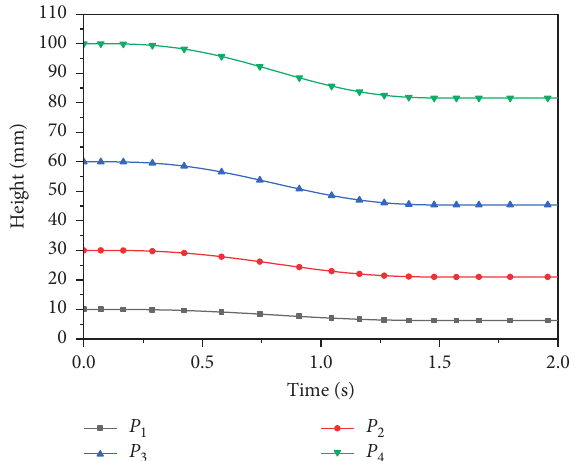
Figure 6: Time evolution of the height of each spring coil endpoint in the compression process.